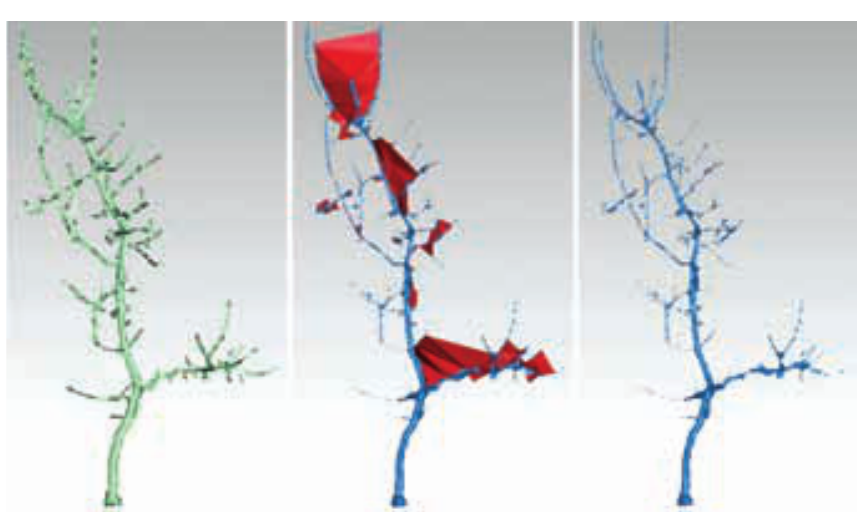
Figure 1. Steps of point cloud processing in Geomagic Studio 12 software environment